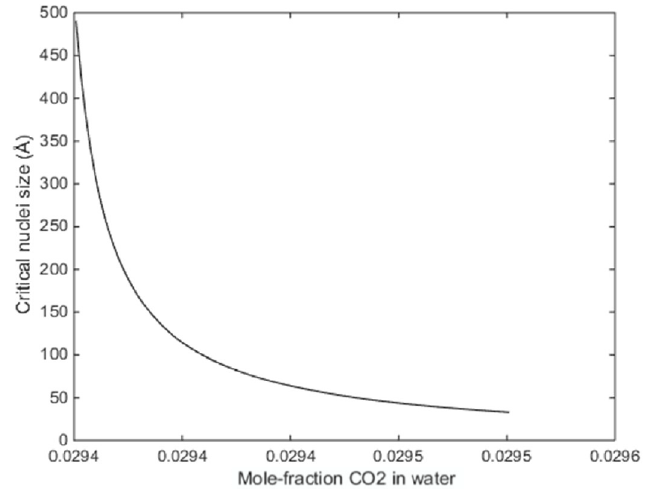
Figure 13. Calculated critical radius in the case of homogeneous hydrate formation from liquid water and dissolved CO 2 at 280 K and 100 bars as function of mole fraction of CO 2 in liquid water.